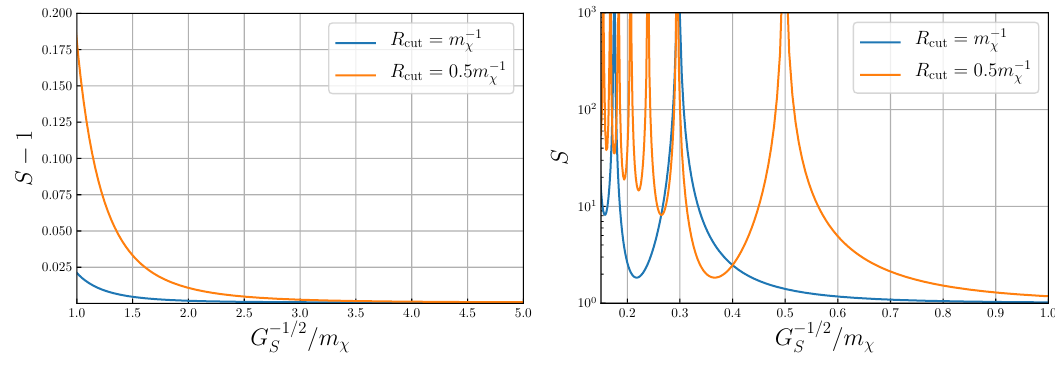
Figure 3 . The Sommerfeld enhancement due to neutrinos forces derived from contact interactions. The left (right) panel shows a small (large) enhancement effect for G − 1 / 2